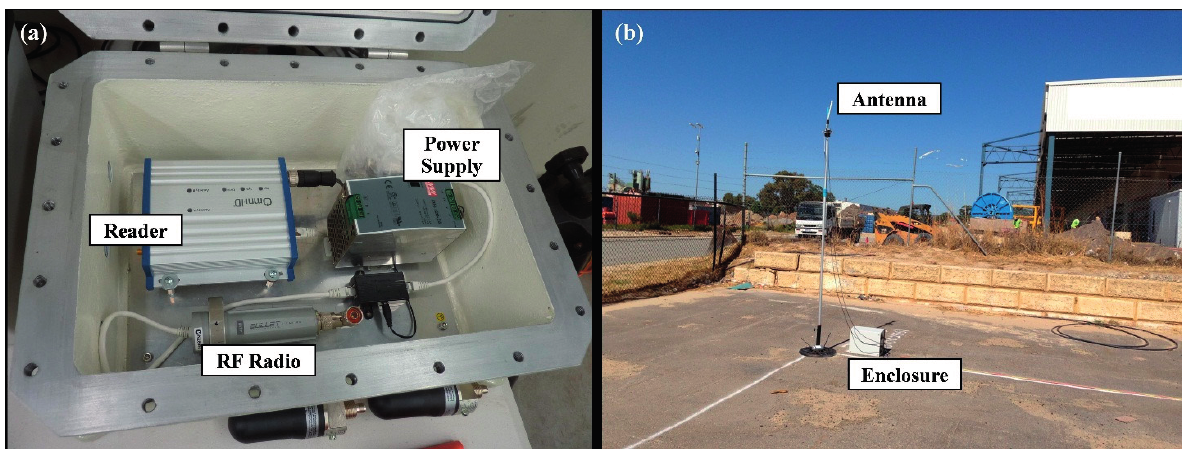
Figure 3. Hardware components: ( a ) the layout of the enclosure; ( b ) antenna and enclosure.